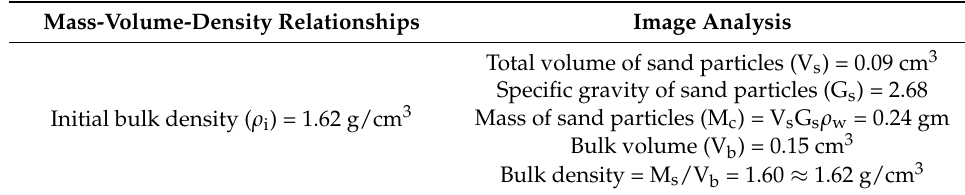
Table 2. Calibration of image data with physical measurement.